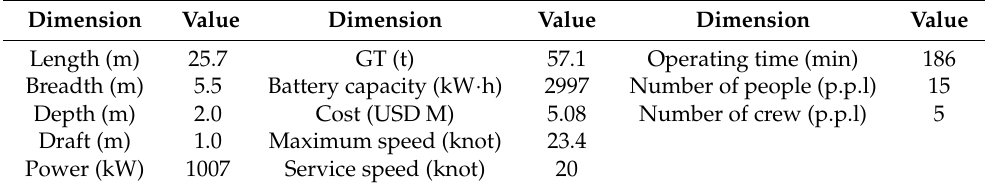
Table 3. Design decisions to meet the functional requirements defined by the operational profiles. Dimension